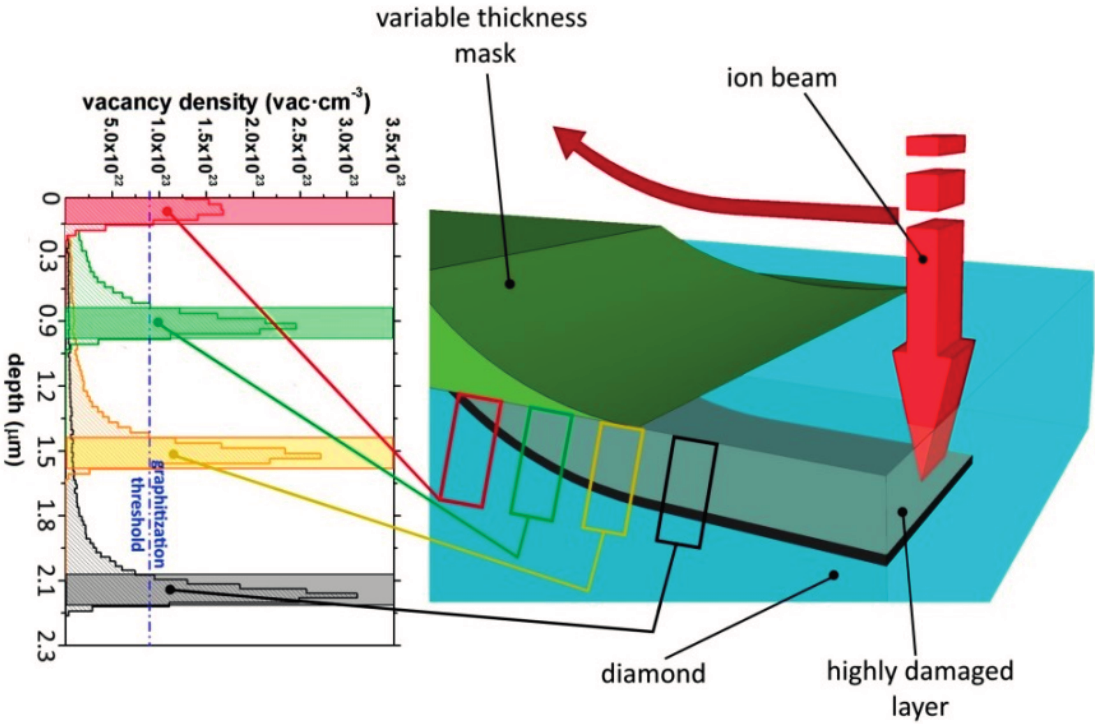
Figure 1. Left: SRIM evaluation of vacancy density pro fi les generated in diamond by 1.2 MeV He + irradiation after crossing a copper mask with increasing thicknesses. The graphitization threshold (9 × 10 22 cm − 3 ) is indicated with a dashed line. Right: schematics of the variable-thickness mask configuration, which allows the de fi nition of the sub-superficial highly damaged layer at variable